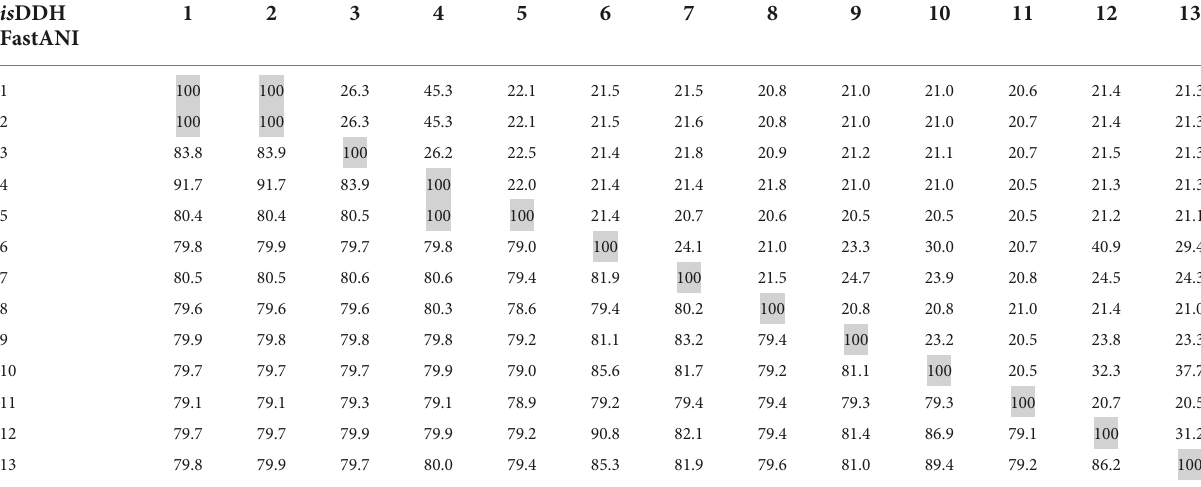
TABLE 1 DNA-DNA similarity values between Winslowiella arboricola sp. nov., Winslowiella iniecta comb. nov., Winslowiella toletana comb. nov., and existing species of the genus Erwinia based on average nucleotide identity (fastANI—lower left) and in silico DNA-DNA hybridisation ( is DDH—upper